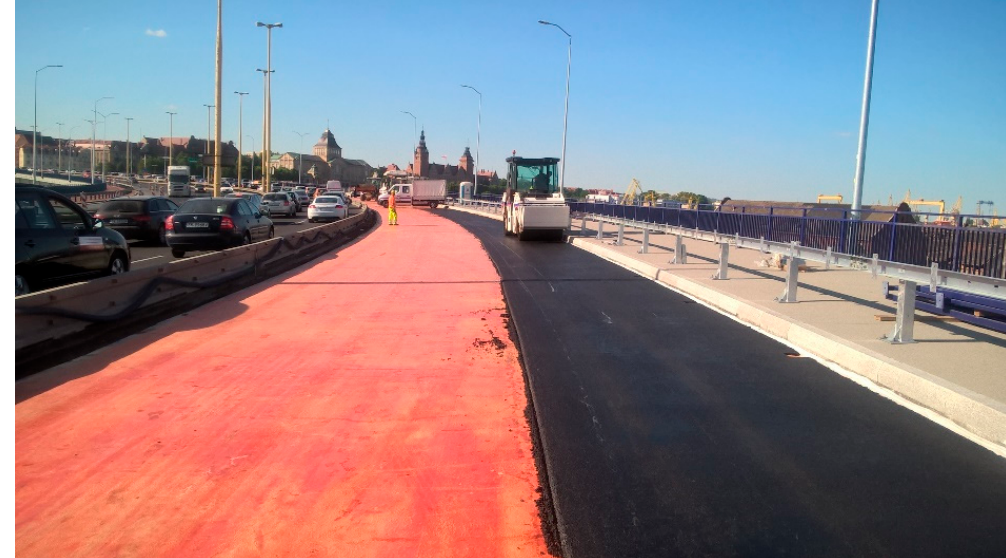
Figure 13. Methyl methacrylate waterproofing layer on the Trasa Zamkowa bridge and SMA-MA 8 layer.